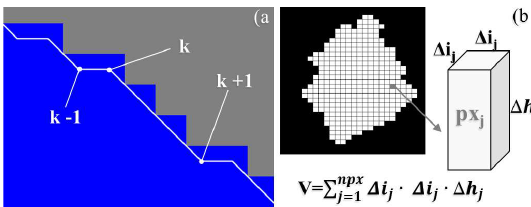
Figure 8. Explanatory drawing of the computation of the geometric parameters. (a) Perimeter, (b) volume.